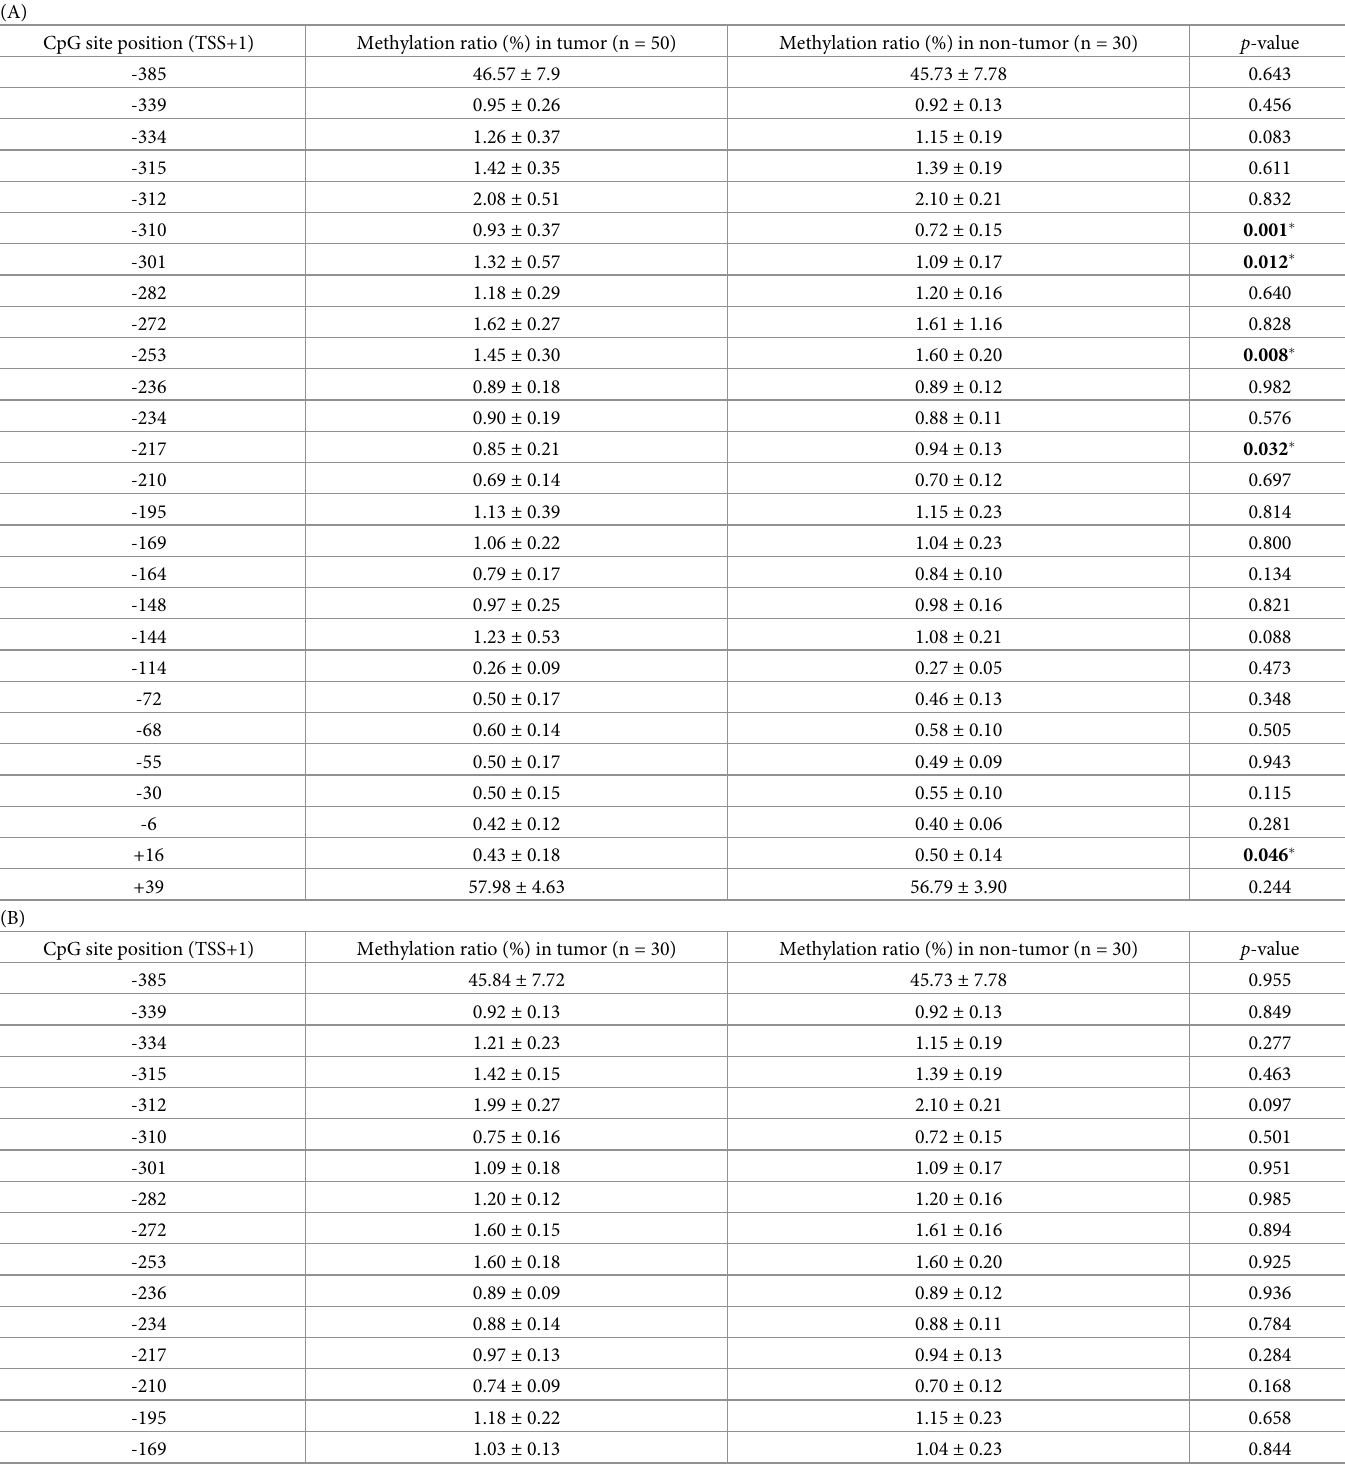
Table 10. Methylation levels of DNA CpG sites in CD44 gene promoter between (A) 50 tumoral vs . non-tumoral tissues; (B) 30 paired tumoral vs . non-tumoral tissues. (A) CpG site position (TSS+1)